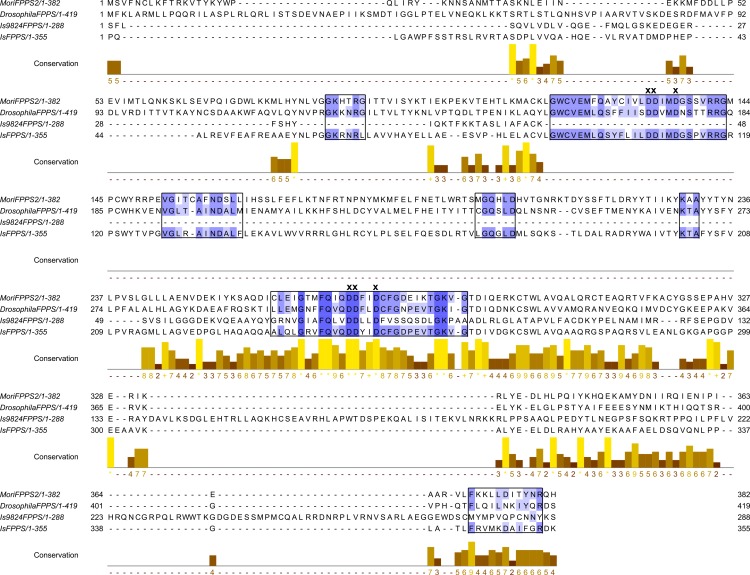
Sequences alignment of farnesyl diphosphate synthase (FPPS2) from Bombyx mori and Drosophila melanogaster with contig 9824 and XP_002408650 from I. scapularis transcriptome and genome.Farnesyl diphosphate synthase (FPPS2) described from Bombyx mori and Drosophila melanogaster aligned with contig 9824 from the I. scapularis transcriptome and FPPS (XP_002408650) from the I. scapularis genome. The boxed regions are the seven prenyltransferase conserved regions previously identified by Koyoma et al. [50]. “X” above the amino acids indicates position of Asp residues within the two aspartate-rich domains. Below the sequence alignment is the conservation panel which is measured as a numerical index (9–0) reflecting the conservation of physicochemical properties in the alignment. * (asterisk) denotes the highest identity score (identical residues in all species) followed by a score of 9 for the next most conserved group of residues containing substitutions by amino acids included in the same physicochemical class as described by Livingstone and Barton [52].